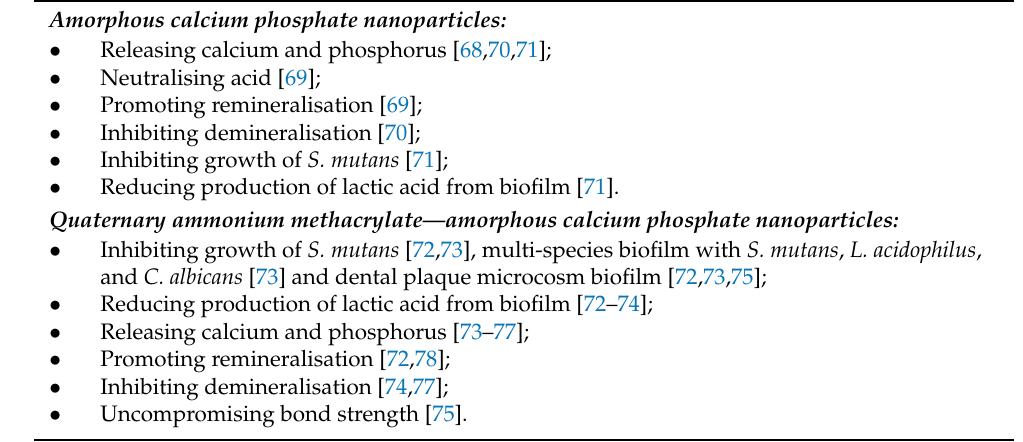
Table 4. Properties of calcium nanoparticles and their related products in caries